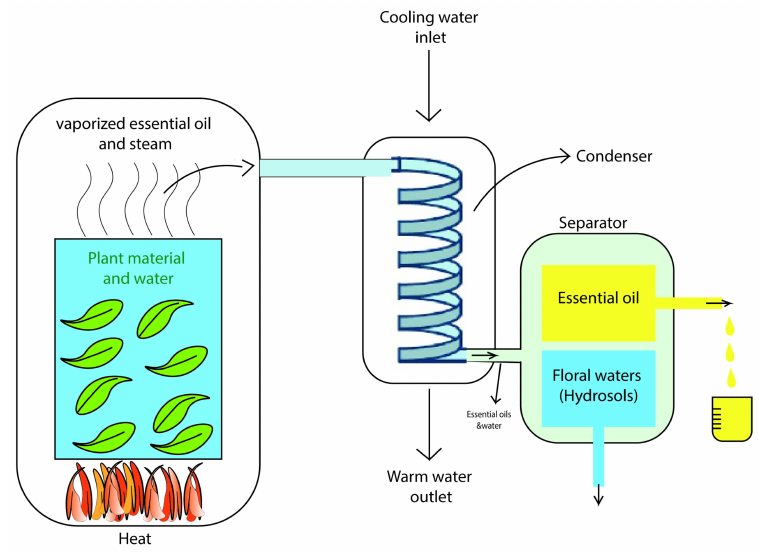
Figure 10. Essential oils processing